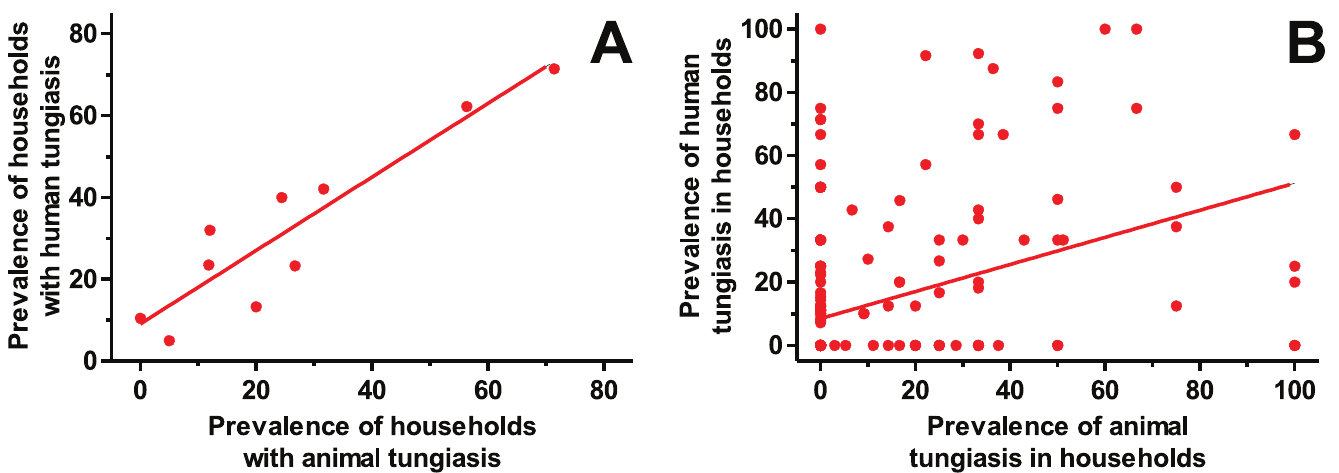
Fig 3. Correlation of prevalence of animal and human tungiasis. (A) Prevalence data of tungiasis in households was analyzed on the village level (rho = 0.85, p = 0.002). (B) Prevalences of tungiasis in humans and animals were compared on the household level (rho = 0.44, p < 0.0001).